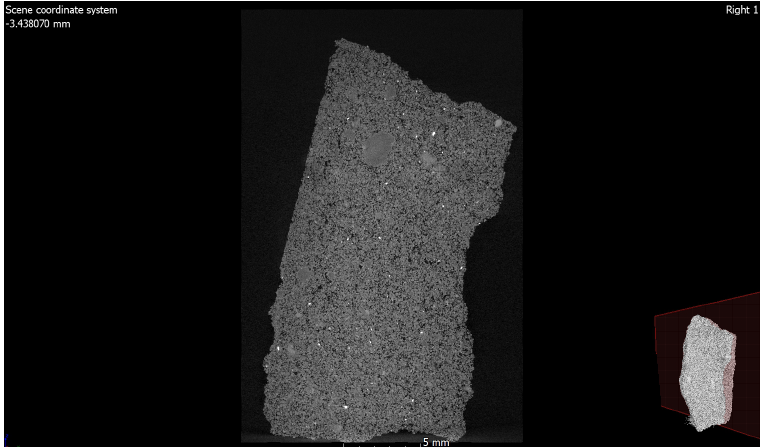
Figure 19. Image of the porous structure of silicate brick with 90% GS.